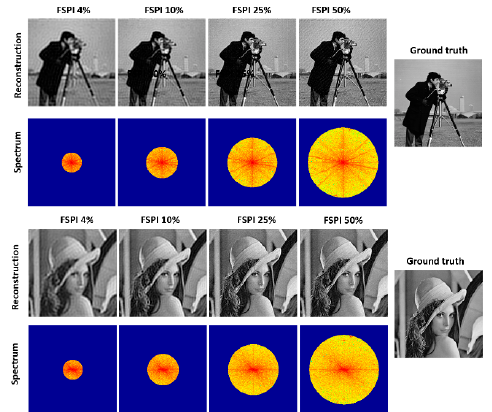
Figure 2. Fourier single pixel imaging (FSPI) reconstruction and amplitude spectrum for cameraman and Lena test images.